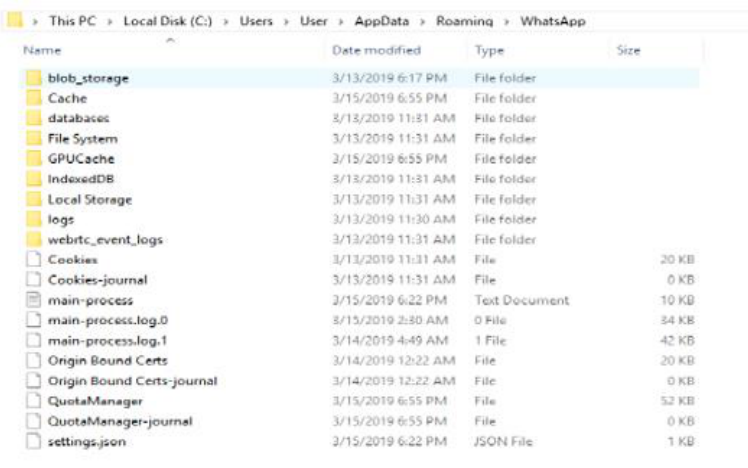
Figure 31. Whatsapp desktop version files on the